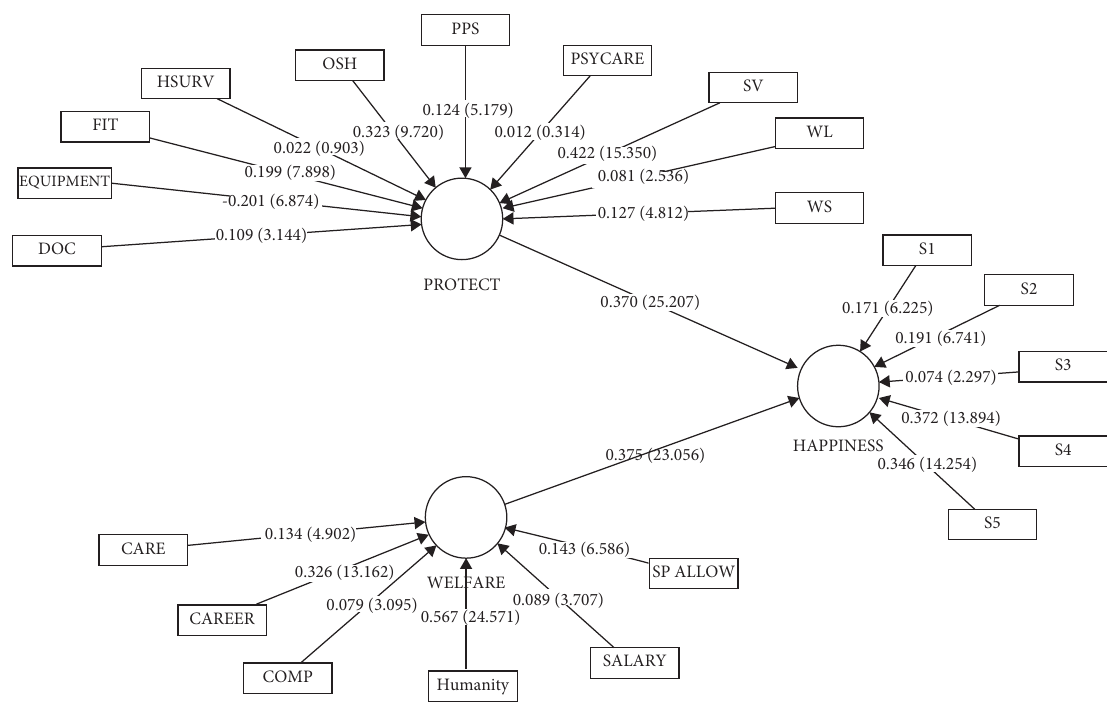
Figure 4: Reflective formative disjoint two-stage structural model. Table 6: Reflective formative disjoint two-stage structural